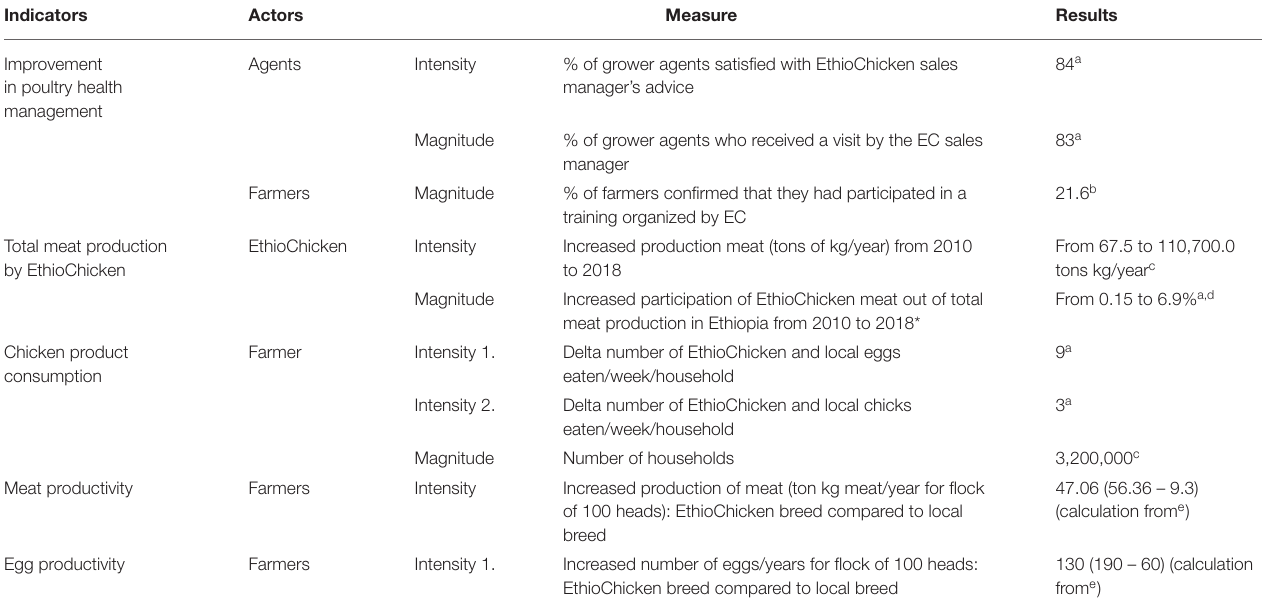
TABLE 3 | Indicators of public health impact related to different stakeholders generated by the PPPs between the Ethiopian government and EthioChicken.